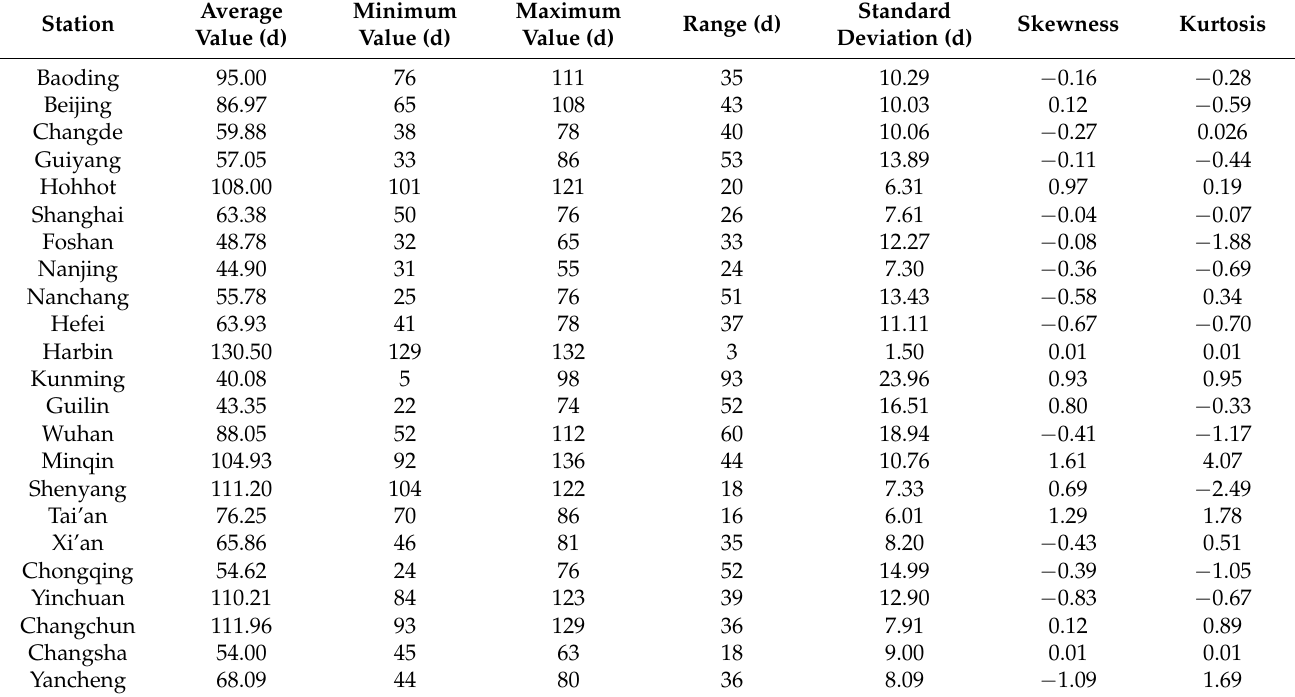
Table 2. Table of ordinal number information of P. orientalis ’ initial flowering period.